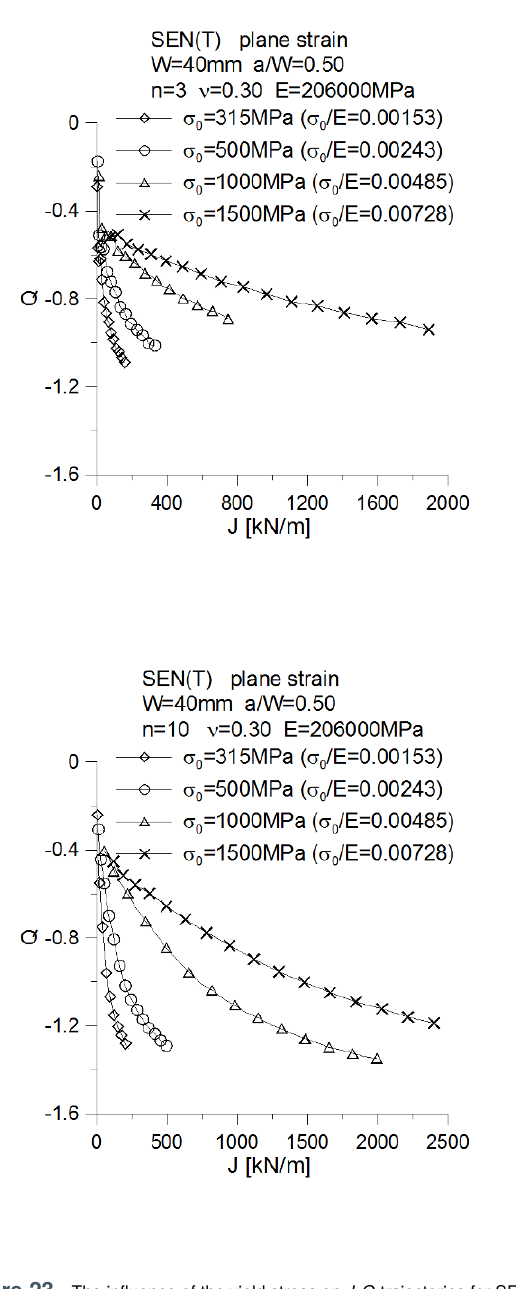
Figure 23. The influence of the yield stress on J - Q trajectories for SEN(T) specimens with crack length a / W =0.50 for different power exponents n in R-O relationship: a) n =3; b) n =5; c) n =10; d) n